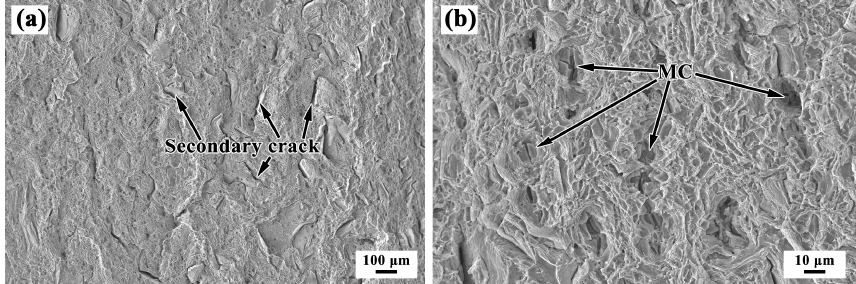
Figure 17. Fractographs of the wrought substrate sample at ( a ) low and ( b ) high magnifications.